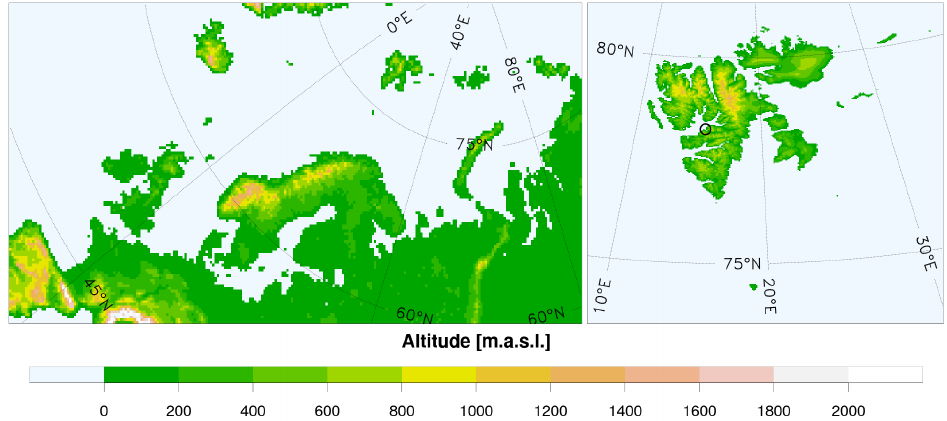
Figure 1. Orography in the intermediate ( left ) and high-resolution ( right ) regional climate model domain. The location of Svalbard Airport is indicated by a circle in the high-resolution